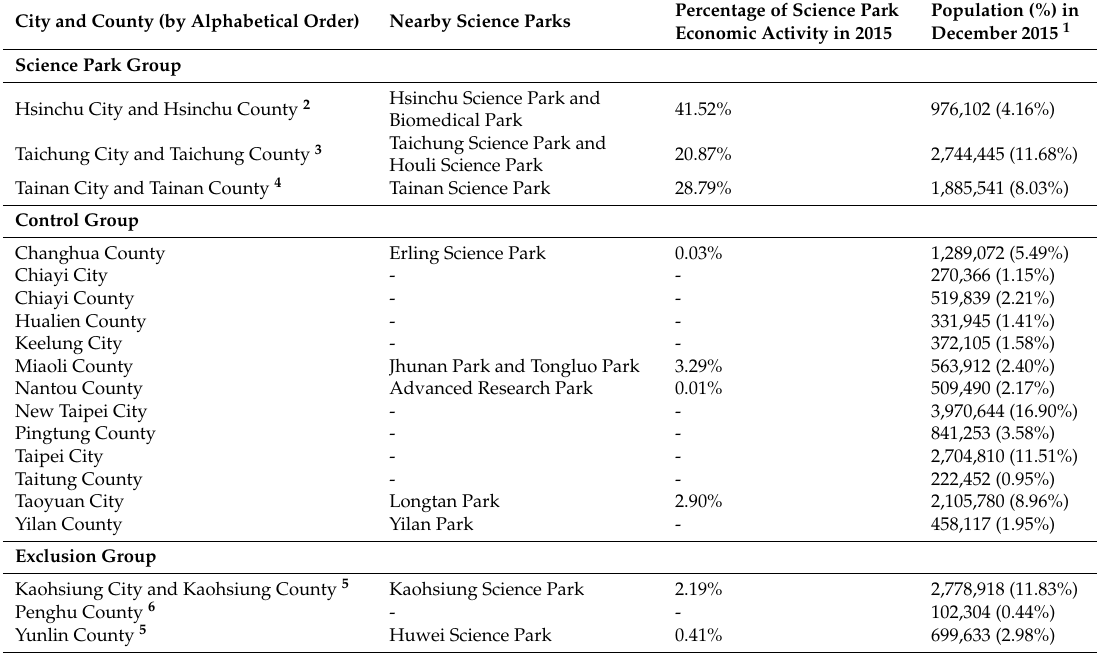
Table 2. Cities and counties in each group and nearby science parks, economic activity, and population. City and County (by Alphabetical